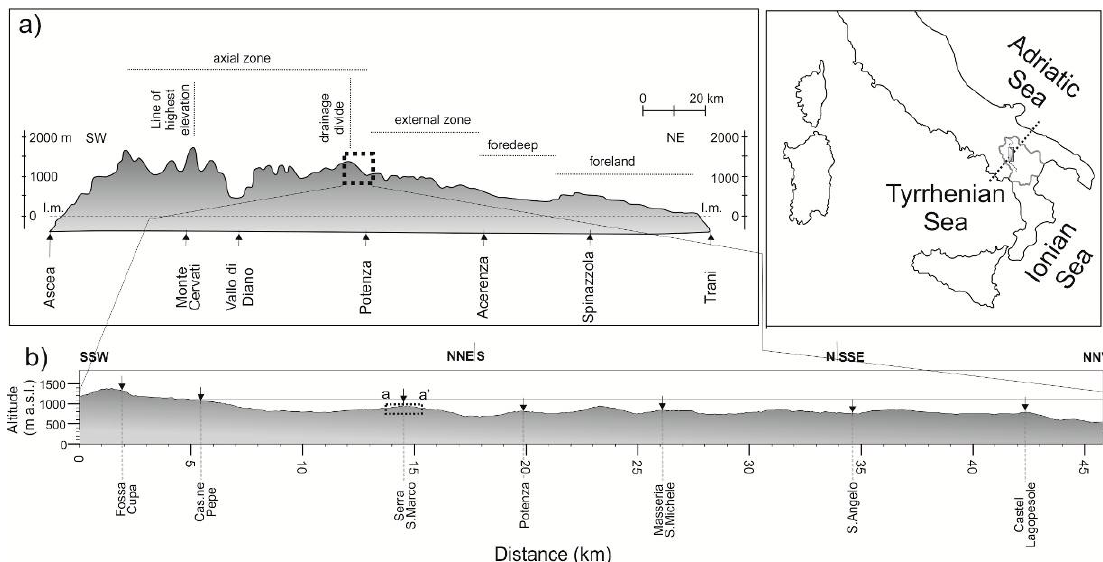
Figure 3. ( a ) Main morphostructural domains crossed along an Apennine transept passing through the study area. ( b ) Topographic profile of the Via Herculia from Sasso di Castalda to Filiano. The dashed box a-a’ indicates the sector of Serra San Marco high, where the roman road crossed a low-angle erosional surface.